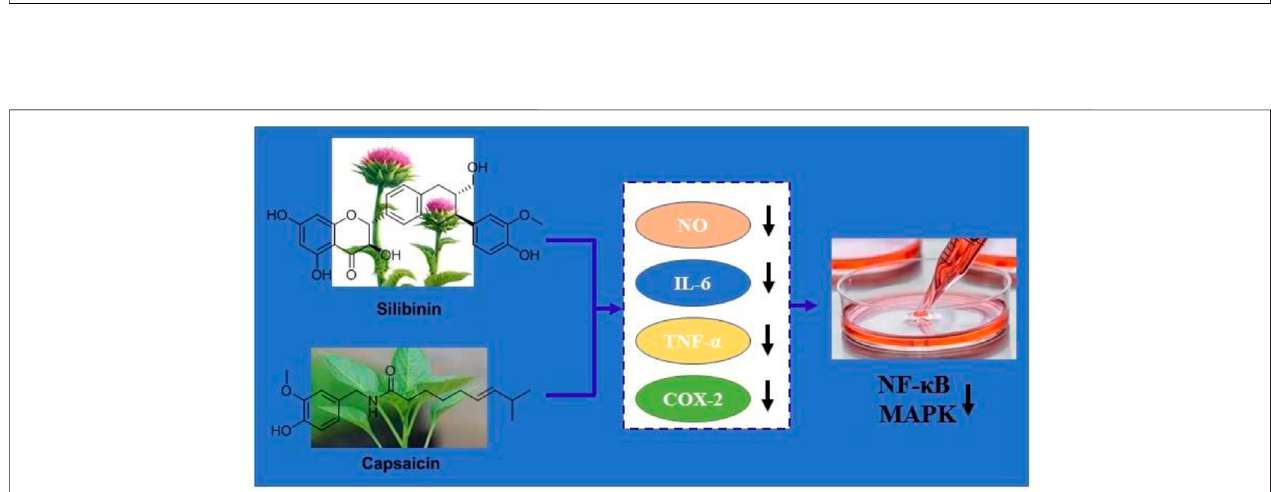
FIGURE 8 | Schematic diagram of the anti-in fl ammation of the silibinin and capsaicin in combination.